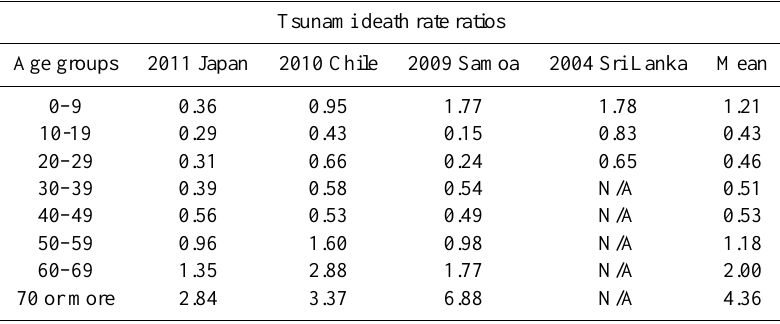
Figure 3. Analysis of mortality by age group (tsunami events of Japan 2011, Chile 2010, Samoa 2009 and Sri Lanka 2004) according to (a) pre-tsunami census; (b) tsunami victims and (c) tsunami death rate ratio ( C = B/A ). The age of tsunami victims over 30 years old in Sri Lanka is not available disaggregated in ranges of 10years, consequently this age range is not represented in the graph. The mean values for this age range are calculated considering only the other three tsunami events. Table 4. Tsunami death rate ratios (Japan 2011, Chile 2010, Samoa 2009 and Sri Lanka 2004). The age of tsunami victims over 30 years old in Sri Lanka is not available (N/A) disaggregated in ranges of 10years; consequently the mean value for this age range is calculated considering only the other three tsunami